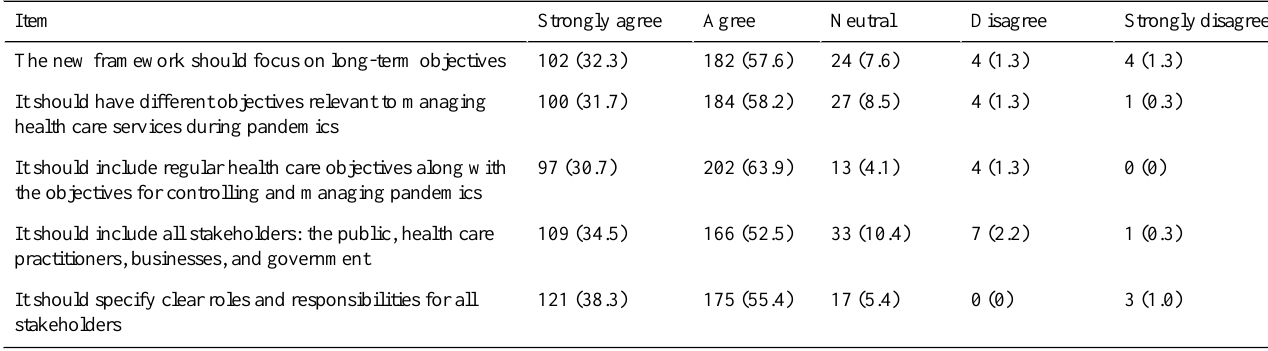
Table 2. Frequency distribution of key considerations related to the national eHealth framework of Saudi Arabia for managing pandemics (N=316), n (%).